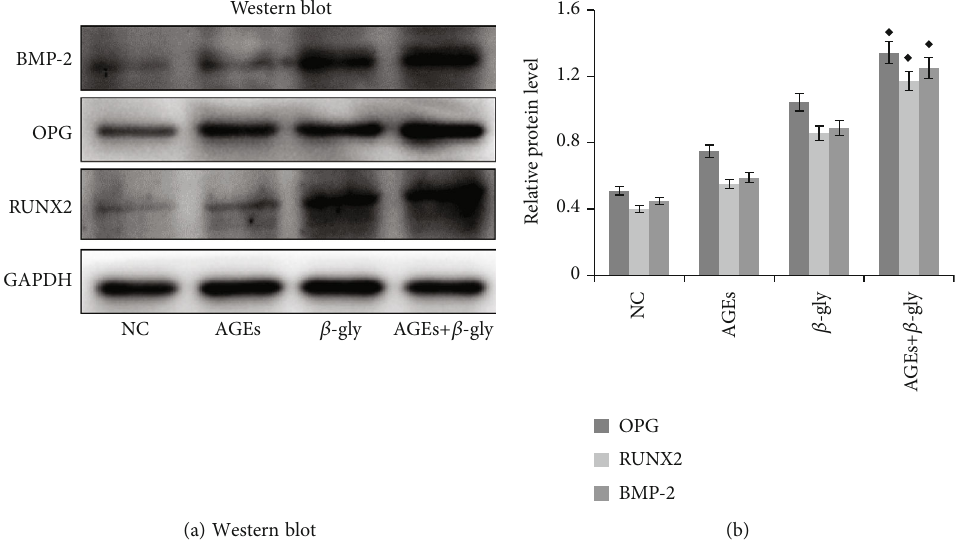
Figure 4: Expression of calci fi cation-related proteins in AGE-induced EPCs. EPCs were induced with 40 mg/l AGE alone (AGEs), with β - gly alone, or with AGEs 40mg/l+ β -gly (10 mmol/l β -gly) for 7 days. (a) Protein expression levels were analyzed by western blotting using antibodies against OPG, RUNX2, or BMP-2; GAPDH was used as the loading control. (b) Densitometric analysis of OPG, RUNX2, and BMP-2 protein expression. Each data point represents the results of three independent repeats. AGEs 40mg/l+ β -gly compared with the other three groups, ♦ P < 0 : 05 vs. the other three groups. AGE: advanced glycation end product; β -gly: β -glycerophosphate; EPC: endothelial progenitor cell; NC: negative control; OPG: osteoprotegerin; RUNX2: runt-related transcription factor 2.